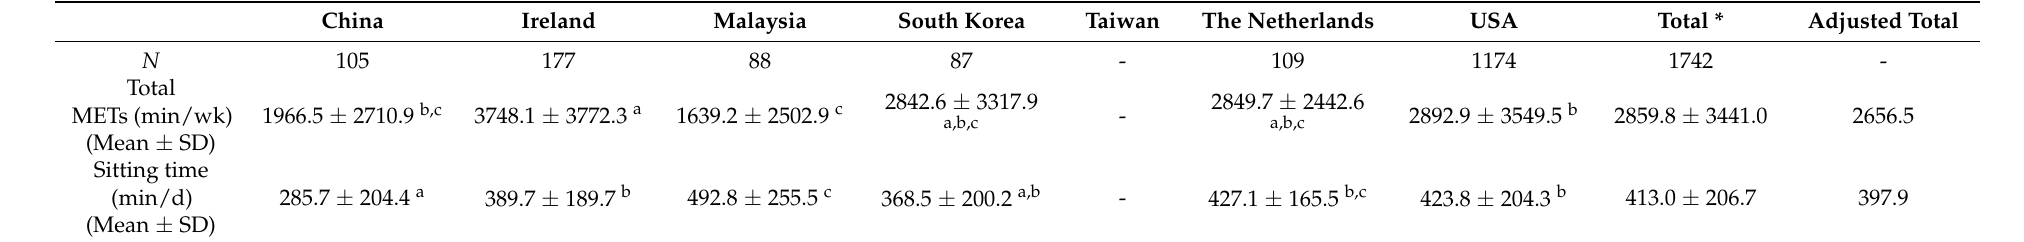
Table 4. Country comparisons of physical activity level and sitting